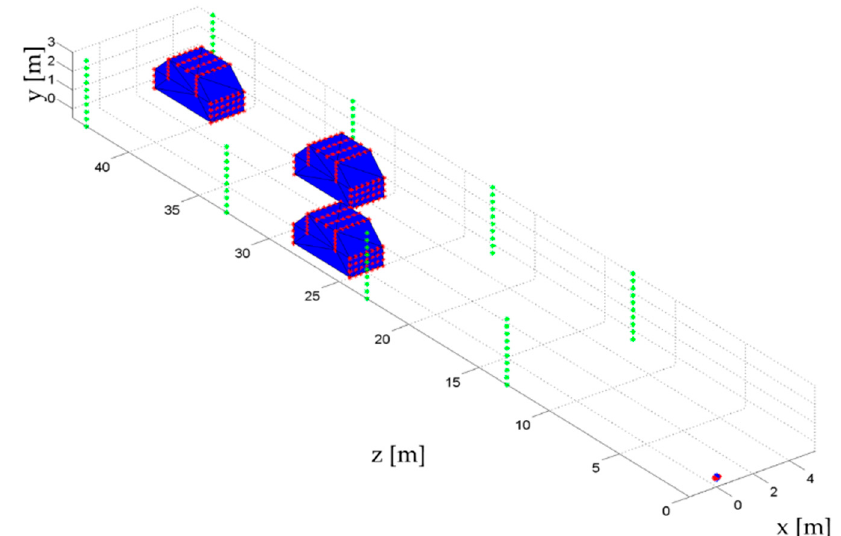
Figure 6. Realistic simulated scenario. Scatterers are positioned in order to simulate a road with cars (red points) and lampposts (green points). Car volume has been marked in blue.